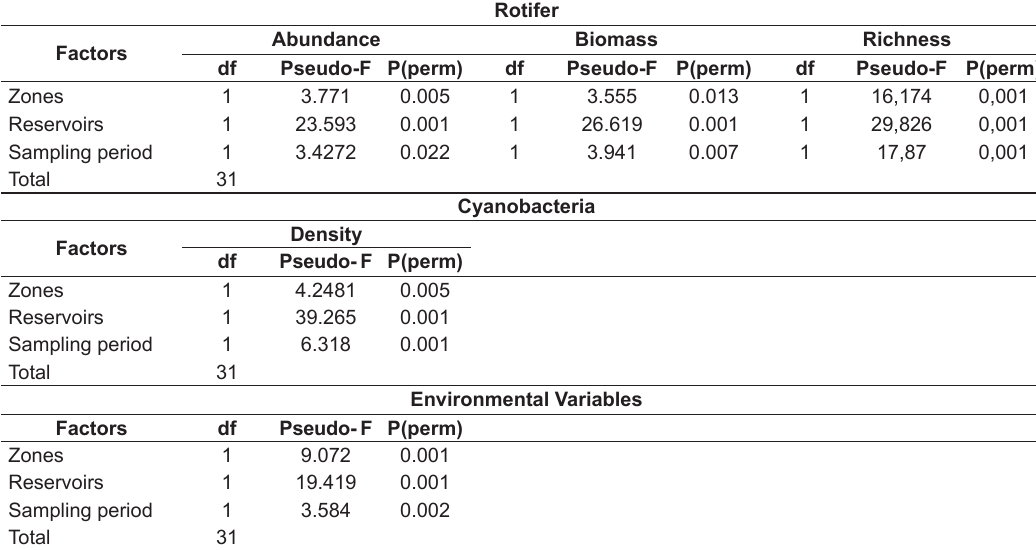
Table 5. Results of PERMANOVA for the structural aspects of the rotifers, density of Cyanobacteria and environ- mental variables in different zones, reservoirs and sampling